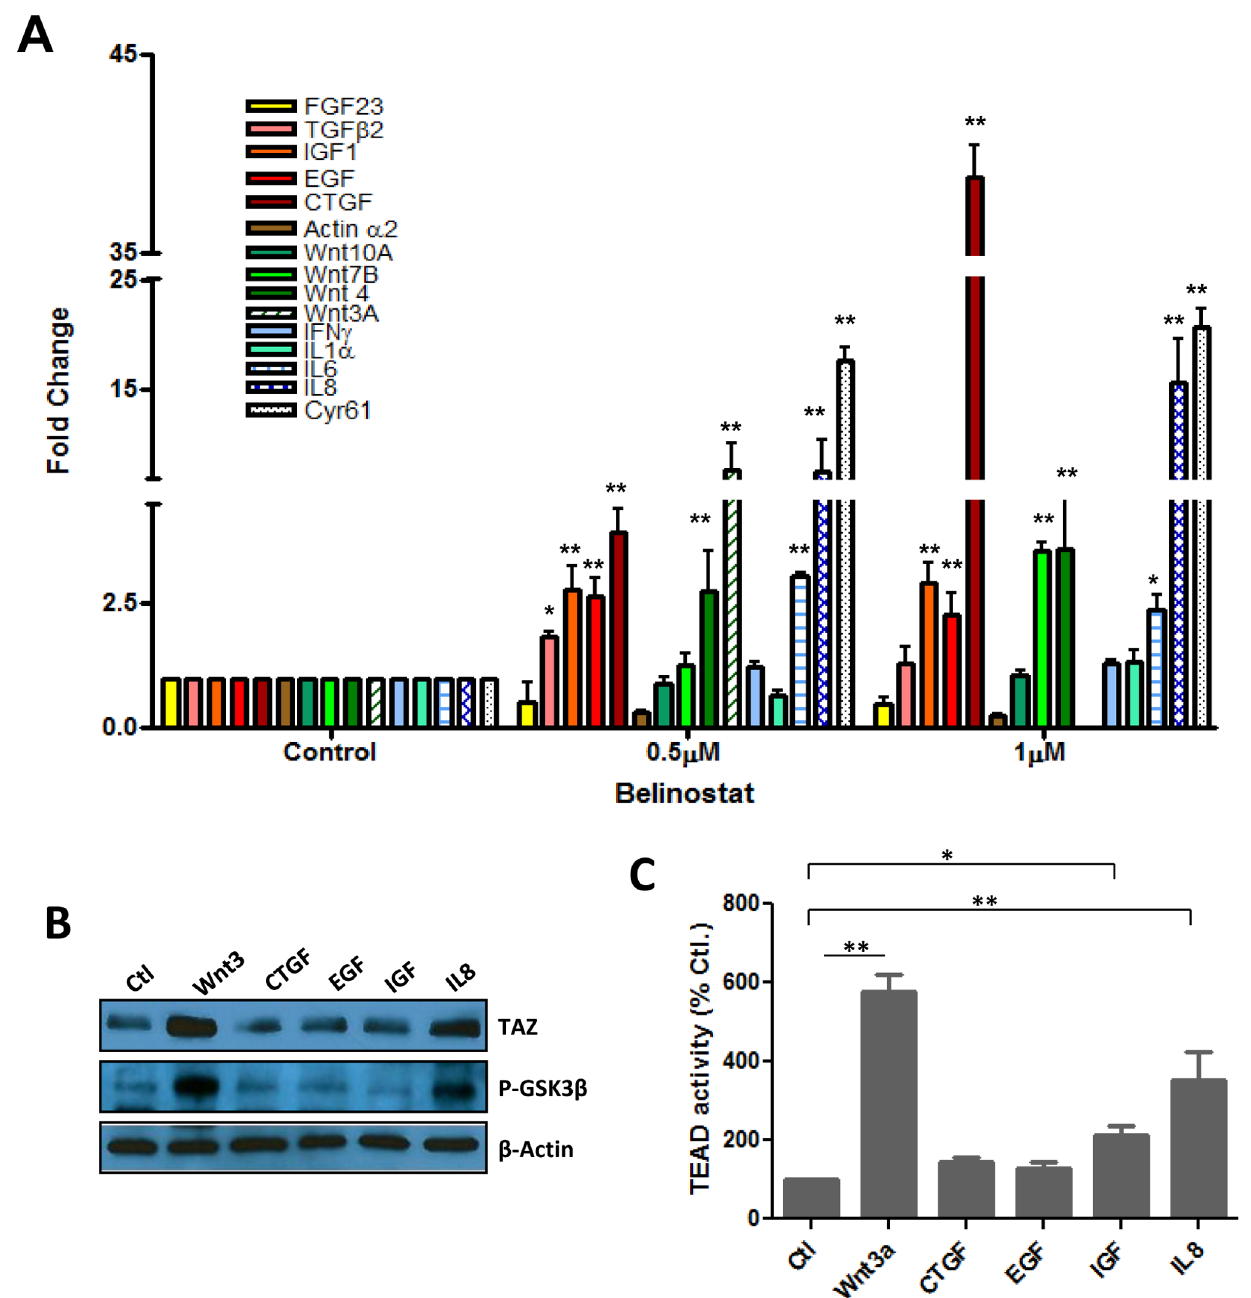
Figure 5. Role of secreted growth factors and cytokines in mediating Belinostat-induced activation of the Hippo pathway. Panel A. SW480 cells were incubated with the indicated concentrations of Belinostat for 24 hours and expression levels of selected secreted factors were determined by QPCR and compared to those in control non-treated cells. Panel B. Effect of individual growth factors and cytokines on TAZ levels and phosphorylation of GSK 3 beta. Cells were incubated with the indicated soluble factors (at 100 ng/ml each) for 24 hours and proteins extracted and processed for western blot using specific antibodies to TAZ and phosphorylated GSK3 beta. Panel C. Effect of individual growth factors and cytokines on activity of the Hippo reporter. Cells transfected with the reporter construct were incubated with the indicated factors for 24 hours and luciferase activity measured as described in the Methods section. Each bar in Panels A and C represents the average of three determinations 6 SE. Statistical significance is shown for treated cells compared to the corresponding untreated controls (*p , 0.05, **p ,